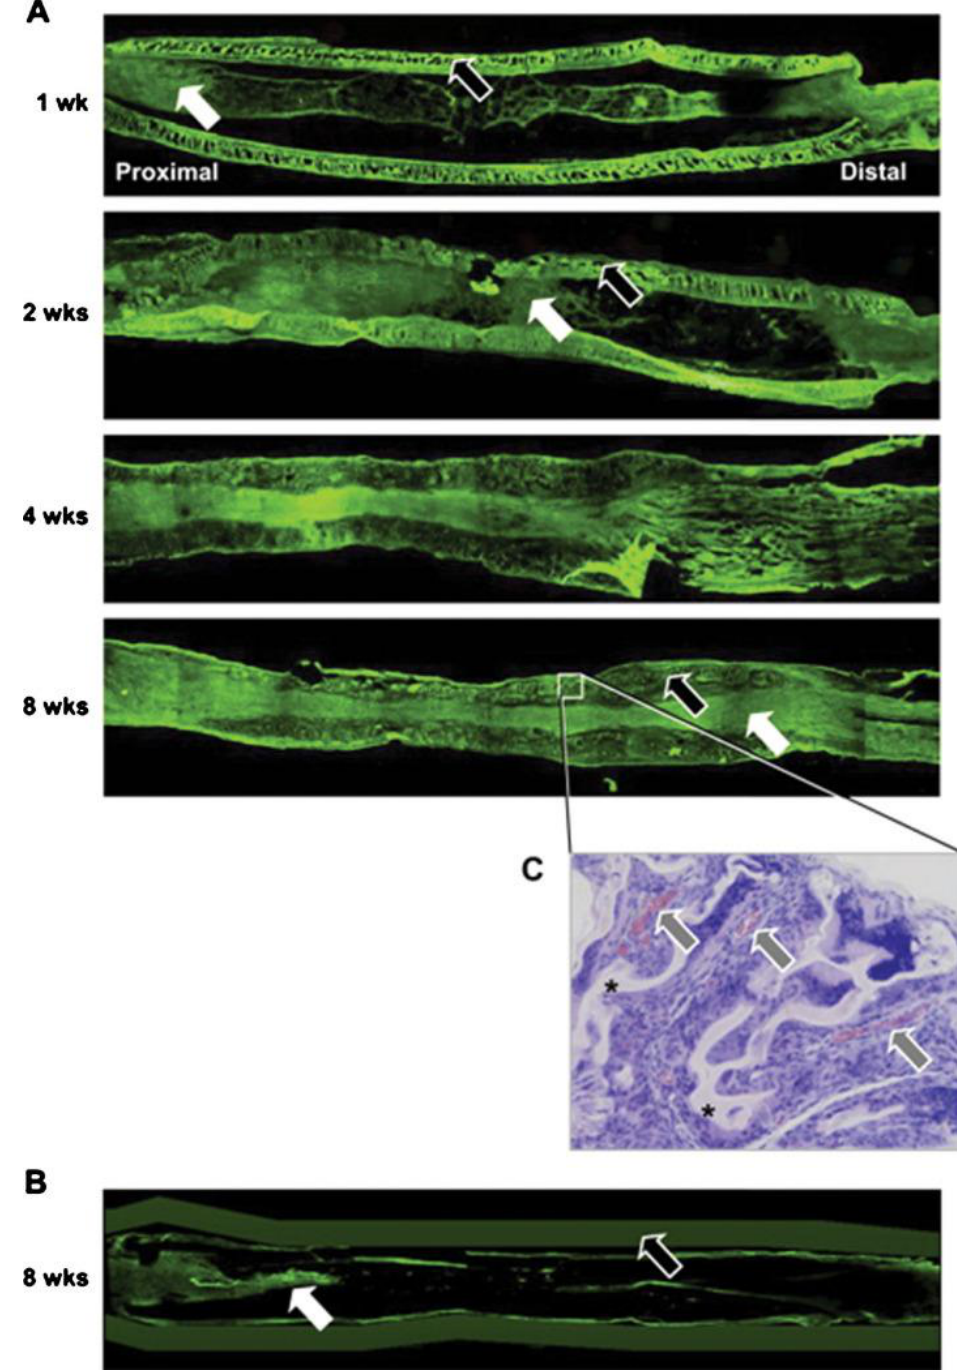
Figure 8. Nerve regeneration using ( A ) PLGA/F127 and ( B ) silicone tubes (white arrow shows regenerated nerve; black arrow shows tube wall) and ( C ) cross-sectional perspective of PLGA/F127 tube wall exhibiting the presence of blood vessels infiltrated within the wall. Gray arrow denotes blood vessel; * denotes PLGA/F127. The image has been taken from the publication by Kim et al. [22] with